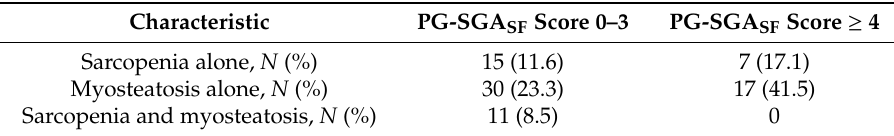
Table 4. Prevalence of sarcopenia and myosteatosis by PG-SGA SF